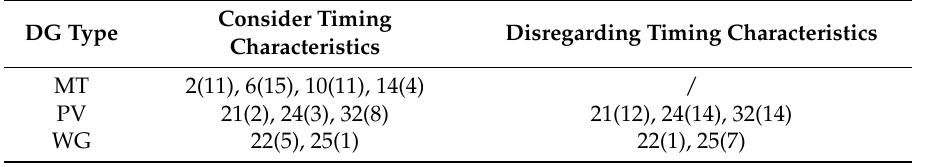
Table 3. Planning schemes.